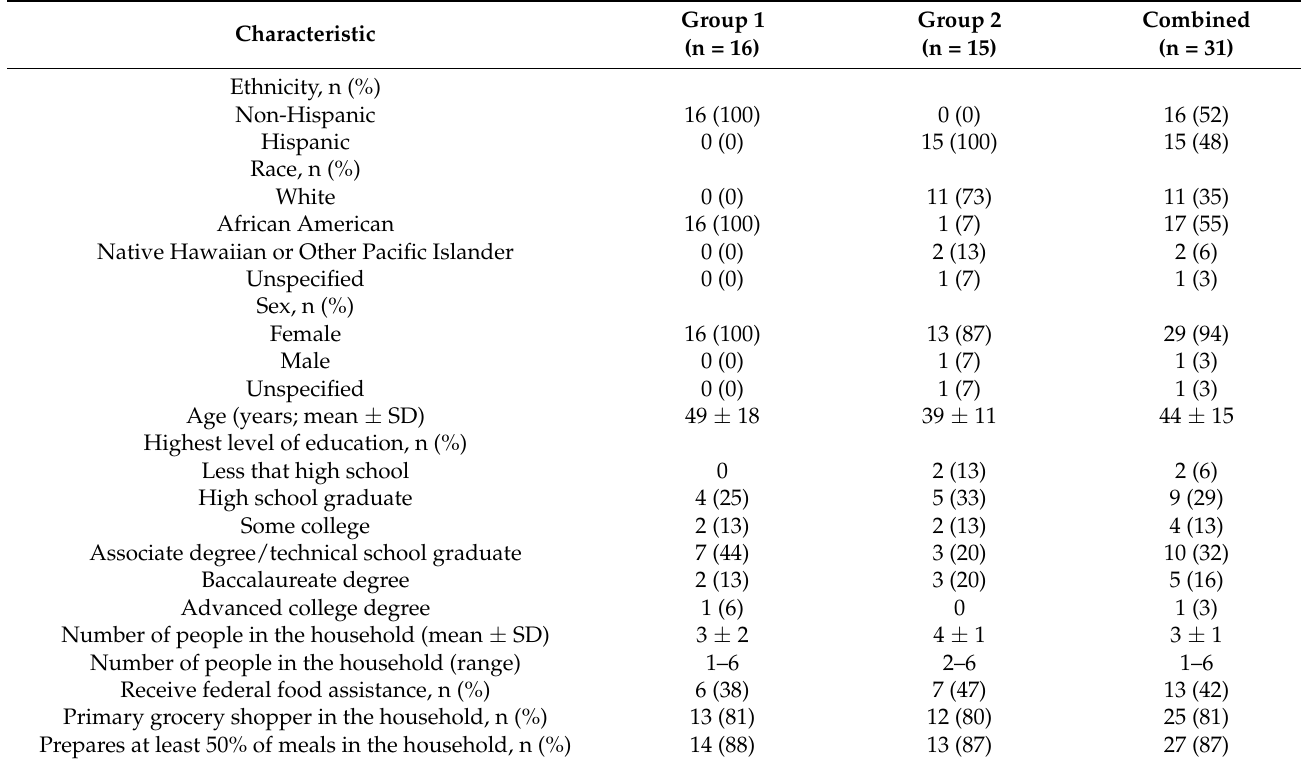
Table 1. Participant sociodemographic